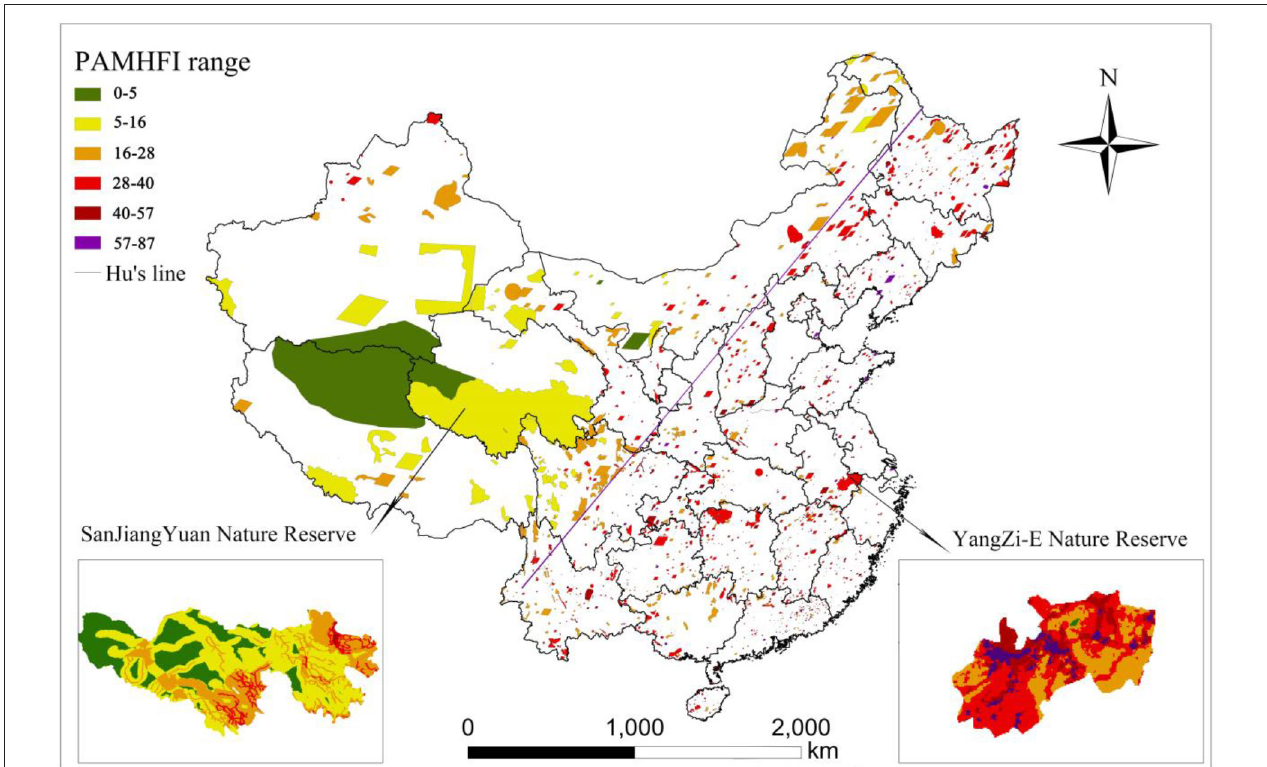
FIGURE 1 | Spatial distribution of PAs coded by Protected Area Mean Human Footprint Index, PAMHFI. Colors represent 1 σ PAMHFI bands (Table S1, Figure S2).